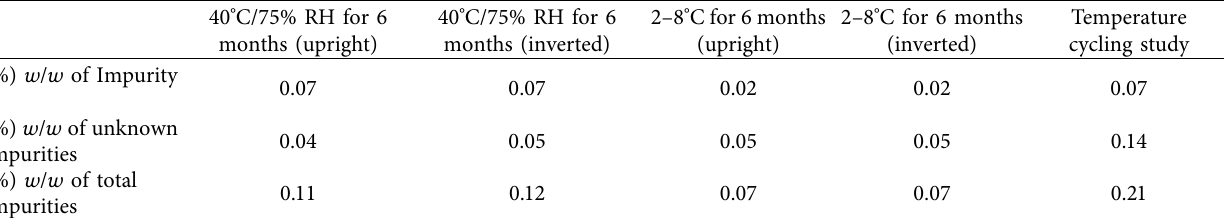
Table 11: Accelerated stability study of NMS injection studied for 6 months at various temperature and humidity conditions and temperature cycling study.